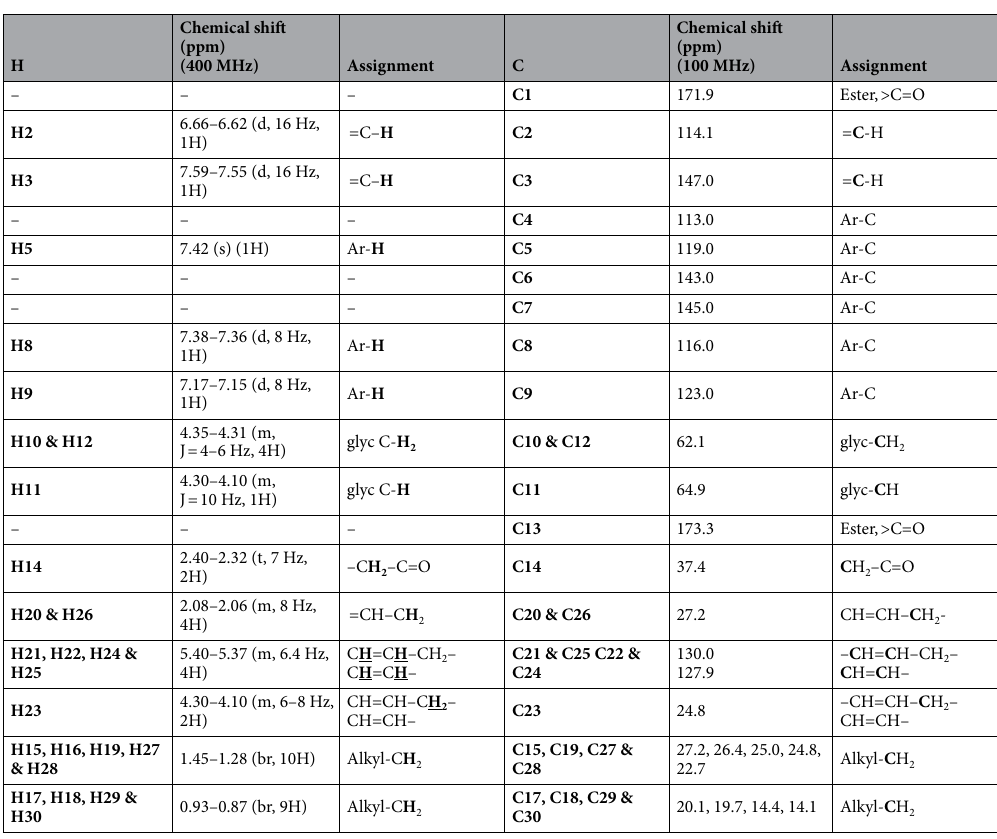
Table 1. 1 H and 13 C NMR assignments for C 1 (CDCl 3 , 400